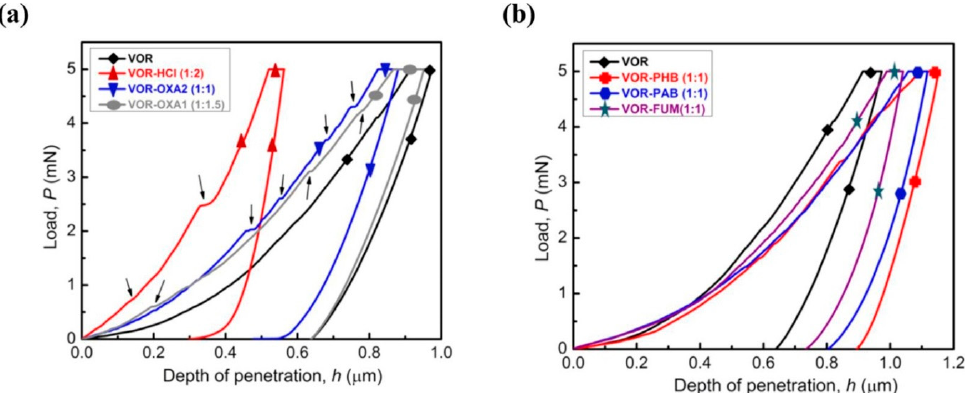
Figure 13. Representative P − h curves obtained on voriconazole and its ( a ) salts and ( b ) cocrystals. (Reproduced with permission from Elsevier, Reference 93).